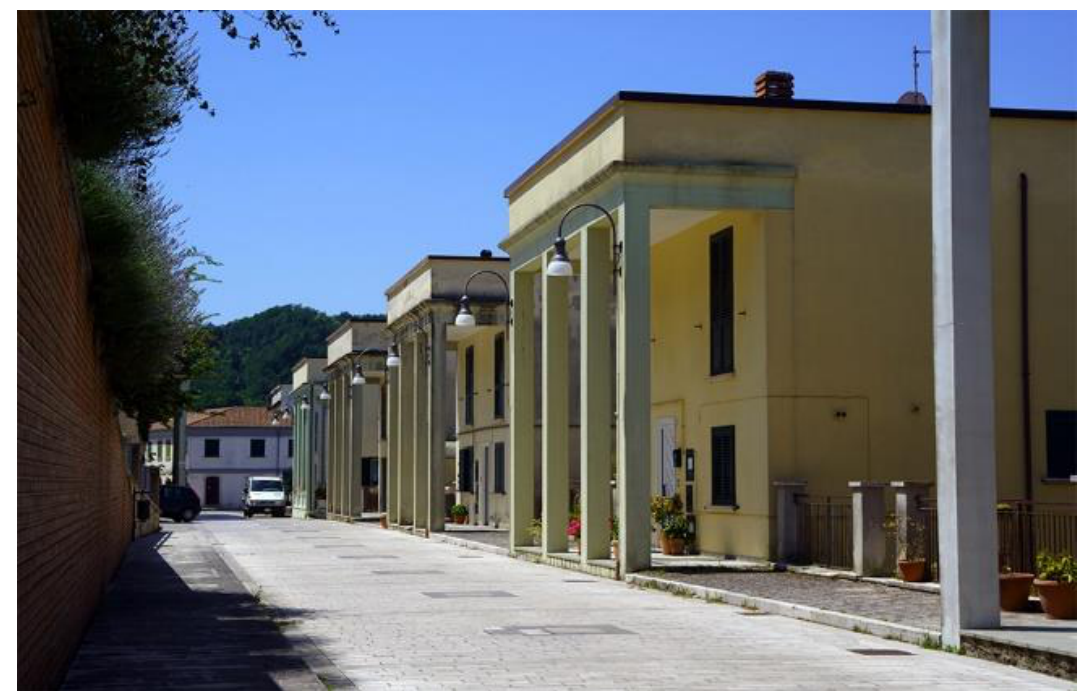
Figure 104. Teora: new reinforced concrete houses (photos by [35,36].